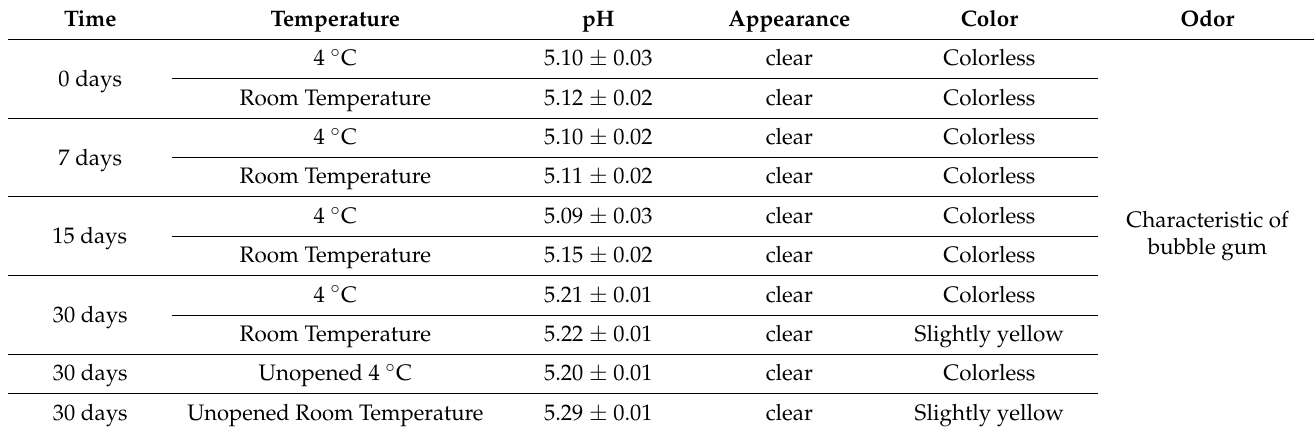
Table 1. Results of the stability evaluation of the oral pediatric ranitidine 25 mg/mL solution.